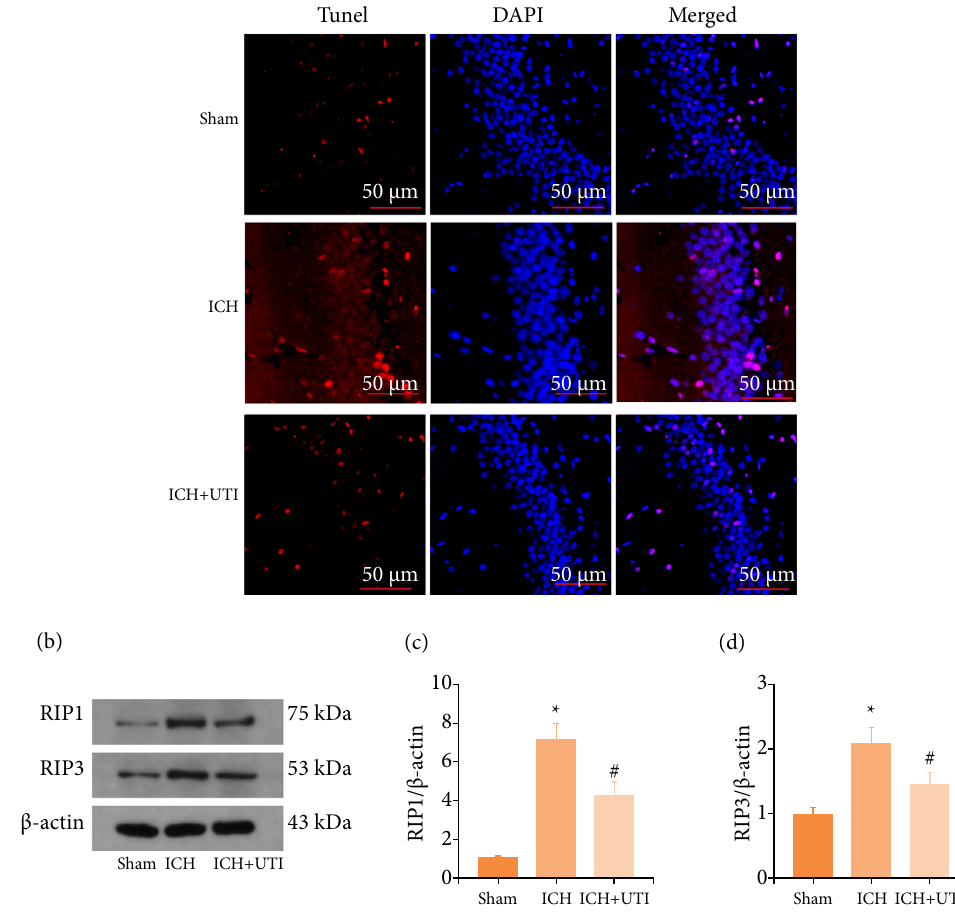
Figure 3 - UTI alleviates neuronal necroptosis after ICH. (a) TUNEL staining showed that UTI alleviated neuronal apoptosis in the hippocampus at 72 h after ICH, and representative images of apoptotic neurons are shown. Scale bar = 50 μ m; (b) Levels of RIP1 and RIP3 in the brain cortex of mice after TBI were determined using Western blotting; (c) Quantification of RIP1 levels in the brain cortex relative to β -actin, the loading control; (d) Quantification of RIP3 levels in the brain cortex relative to β -actin. DAPI, 4’,6-diamidino-2-phenylindole; SAH, subarachnoid hemorrhage; TUNEL, terminal deoxynucleotidyl transferase dUTP nick end